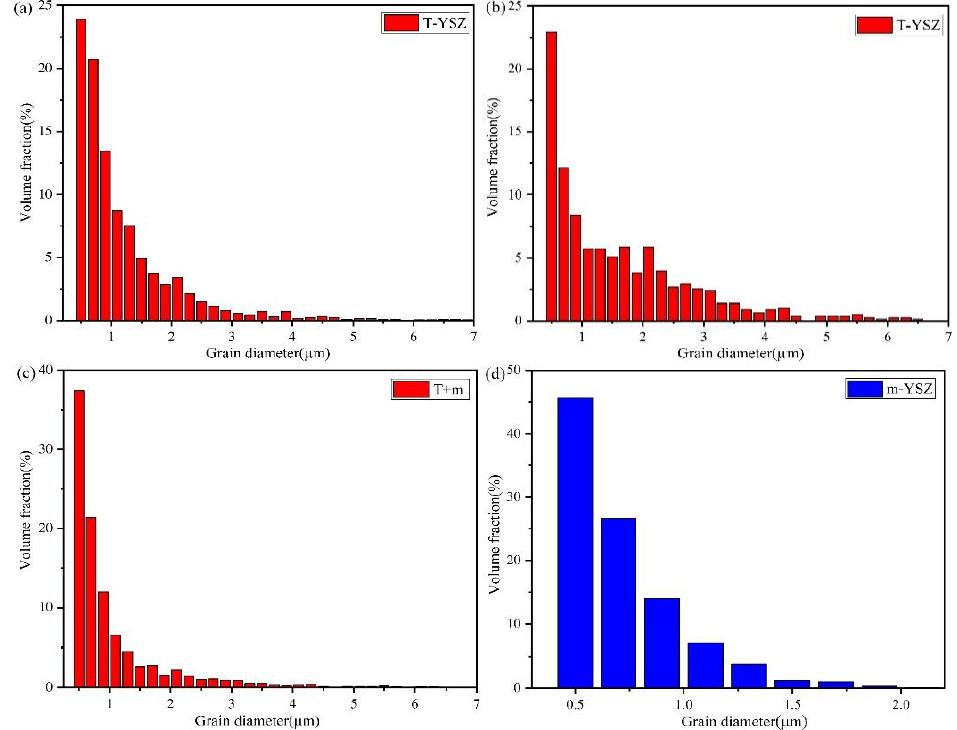
Figure 12. Grain size of YSZ coatings before and after thermal treatment: ( a ) as-sprayed; ( b , c , d ) 1550 ( b – d ) 1550 ◦ C / 100 h. T (tetragonal phase) is meant as a group of t, t (cid:48) and t” phases; m (monoclinic °C/100 h. T (tetragonal phase) is meant as a group of t, t′ and t″ phases; m (monoclinic phase); T + m phase); T + m represents all grains in the represents all grains in the coating.